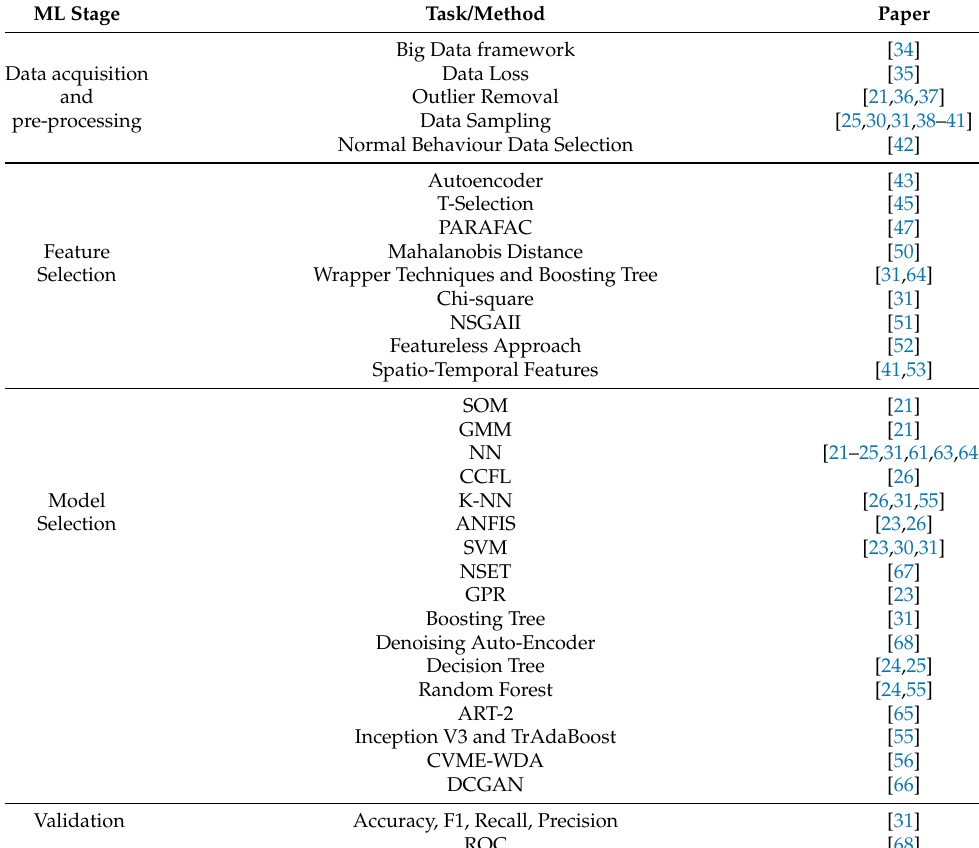
Table 1. Summary of